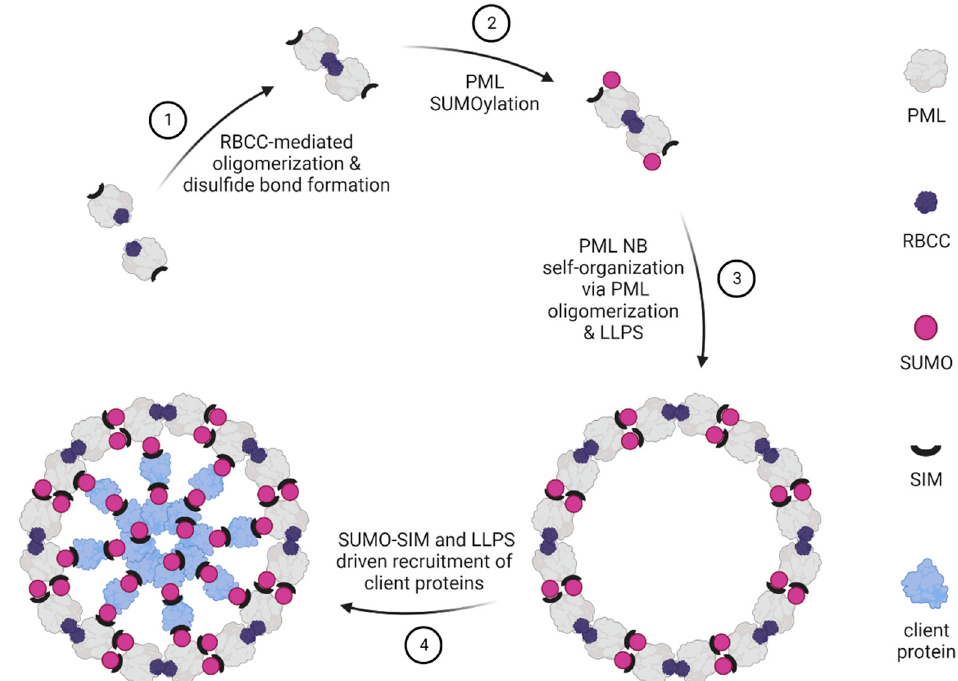
Figure 1. Model of PML nuclear body (NB) assembly. (1) PML NB biogenesis is triggered via oligomerization of PML monomers, which is mediated via oligomerization of the N-terminal RBCC region and disulfide bond formation between cysteines residues. (2) UBC9-dependent PML SUMOylation primes for multivalent intermolecular interactions between SUMO moieties and a SUMO interaction motif (SIM) present in the PML protein. (3) PML NB shell assembly is promoted through polymerization of PML via intermolecular non-covalent interactions and SUMO–SIM interactions. (4) SUMOylated and/or SIM-containing PML NB-associated proteins are recruited to PML NBs through SUMO moieties and SIMs present in PML and its client proteins. Liquid–liquid phase separation (LLPS) controls PML NB biogenesis via phase transition properties of the PML protein itself and SUMO–SIM interaction-driven phase transition.